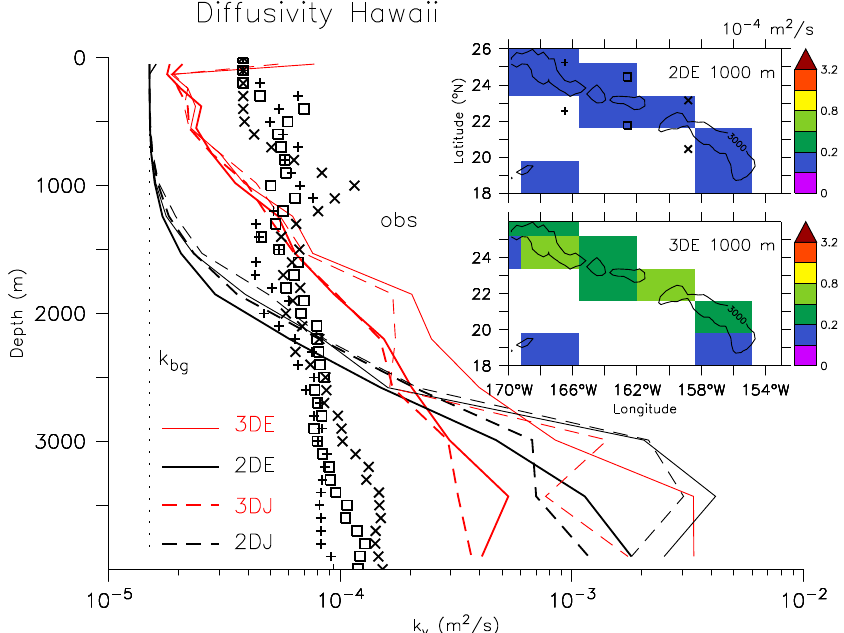
Fig. 9. Comparison of simulated (lines) k v with observations (symbols) for Hawaii. Lines in main panel are horizontal averages of the nonwhite grid points in the inset maps. Both 10d (thick) and equilibrium (model year 4000, thin) solutions are shown. Dotted line indicates the model’s background diffusivity. Insets show horizontal maps of simulated diffusivities at 1km depth. Contour lines show the 3km isobath from a 20min resolution data set. Observational estimates were averaged over 2.7 ◦ of latitude in order to correspond to the latitudinal averaging of the climate model results (see insets); 2.7 ◦ was chosen because it is the average latitudinal width of the nonwhite model grid points.